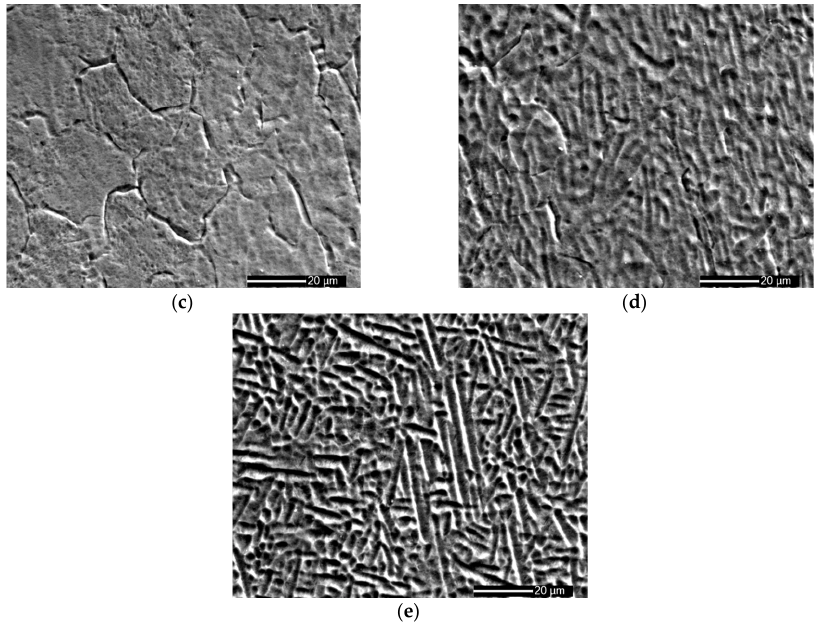
Figure 4. Typical microscopic structures across a friction welded joint with Ti64 and Ti17 alloys: ( a ) Ti64-heat affected zone (HAZ); ( b ) Ti64-thermo-mechanically affected zone (TMAZ); ( c ) weld zone (WZ); ( d ) Ti17-TMAZ and ( e ) Ti17-HAZ.